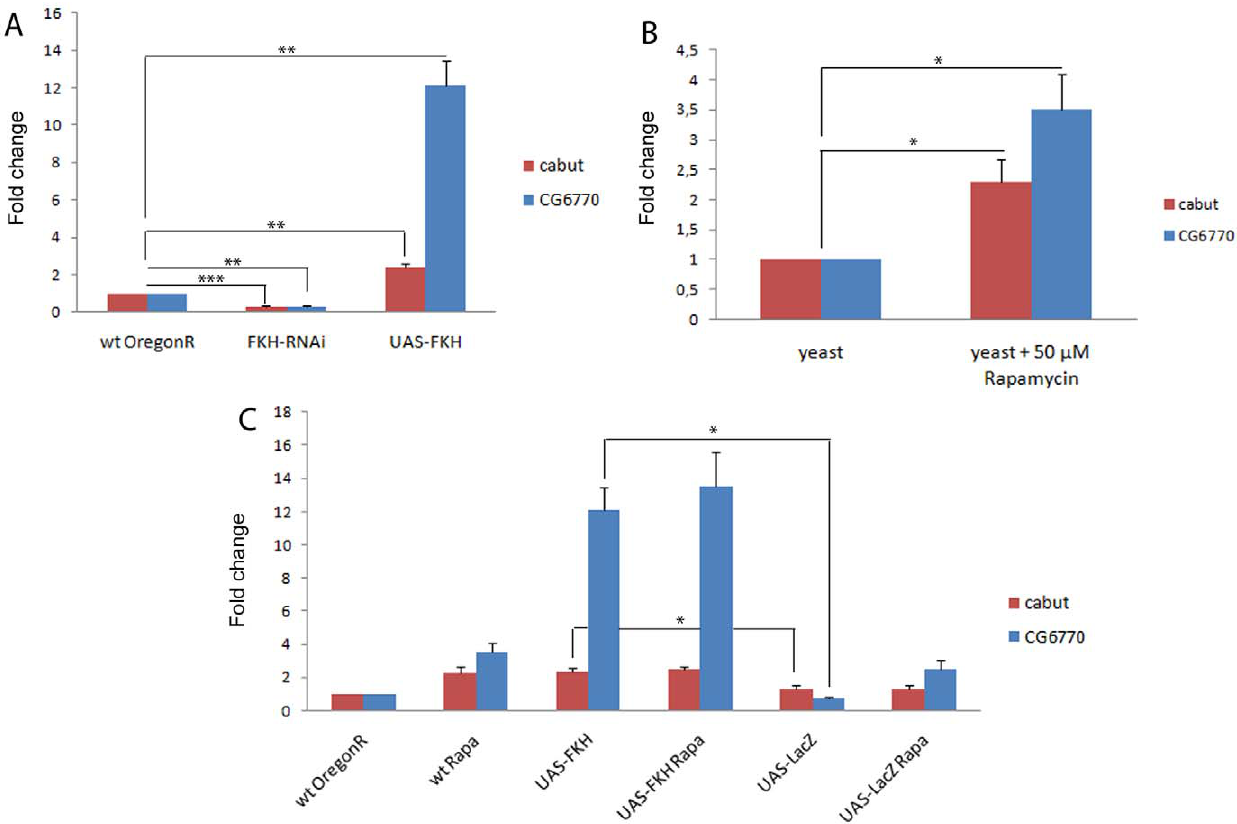
Figure 5. Transcription of CG6770 and cabut is regulated by FKH and rapamycin. Realtime qPCR was performed to quantify mRNAs in larval extracts. ( A ) Compared to wildtype animals, the putative FKH targets CG6770 and cabut are downregulated in yeast-fed larvae with low FKH levels ( w; arm-Gal4/ + ; UAS-FKH-RNAi/ + ) and upregulated in larvae overexpressing FKH ( w;; ppl-Gal4/UAS-FKH ). ( B ) CG6770 and cabut transcription is induced in wildtype larvae fed with 50 m M rapamycin. ( C ) CG6770 and cabut mRNA levels are significantly elevated upon rapamycin treatment and in larvae with high FKH levels in comparison to the wildtype and unspecific controls ( w;; ppl-Gal4/UAS-LacZ ). Rapamycin treatment of larvae with high FKH levels has no significant additive effect on target gene expression. Significance was tested using an unpaired 2-tailed Student’s t-test. *=p , 0.05; **=p , 0.01; ***=p , 0.001. Error bars represent SEM.